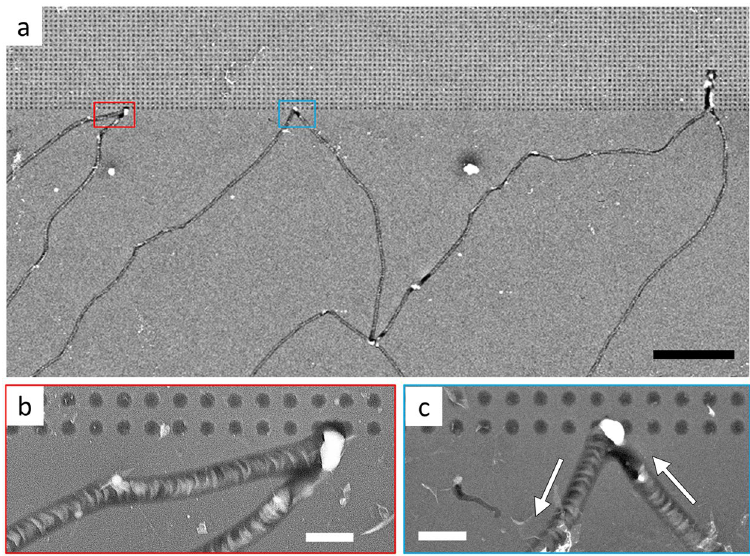
Figure 5. Lateral propagation of micro-explosions in p-Si GOS with a nano-hole array. ( a ) SEM image of micro-explosion-damaged area. Three trails (narrow trenches) propagated toward the nano-hole array patterned area (upper part) and bounced back. Scale bar, 5 µ m. ( b ) Magnified view of the left-most trail. Scale bar, 500 nm. ( c ) Magnified view of the center trail. Damage propagation direction is marked with arrows. Scale bar, 500